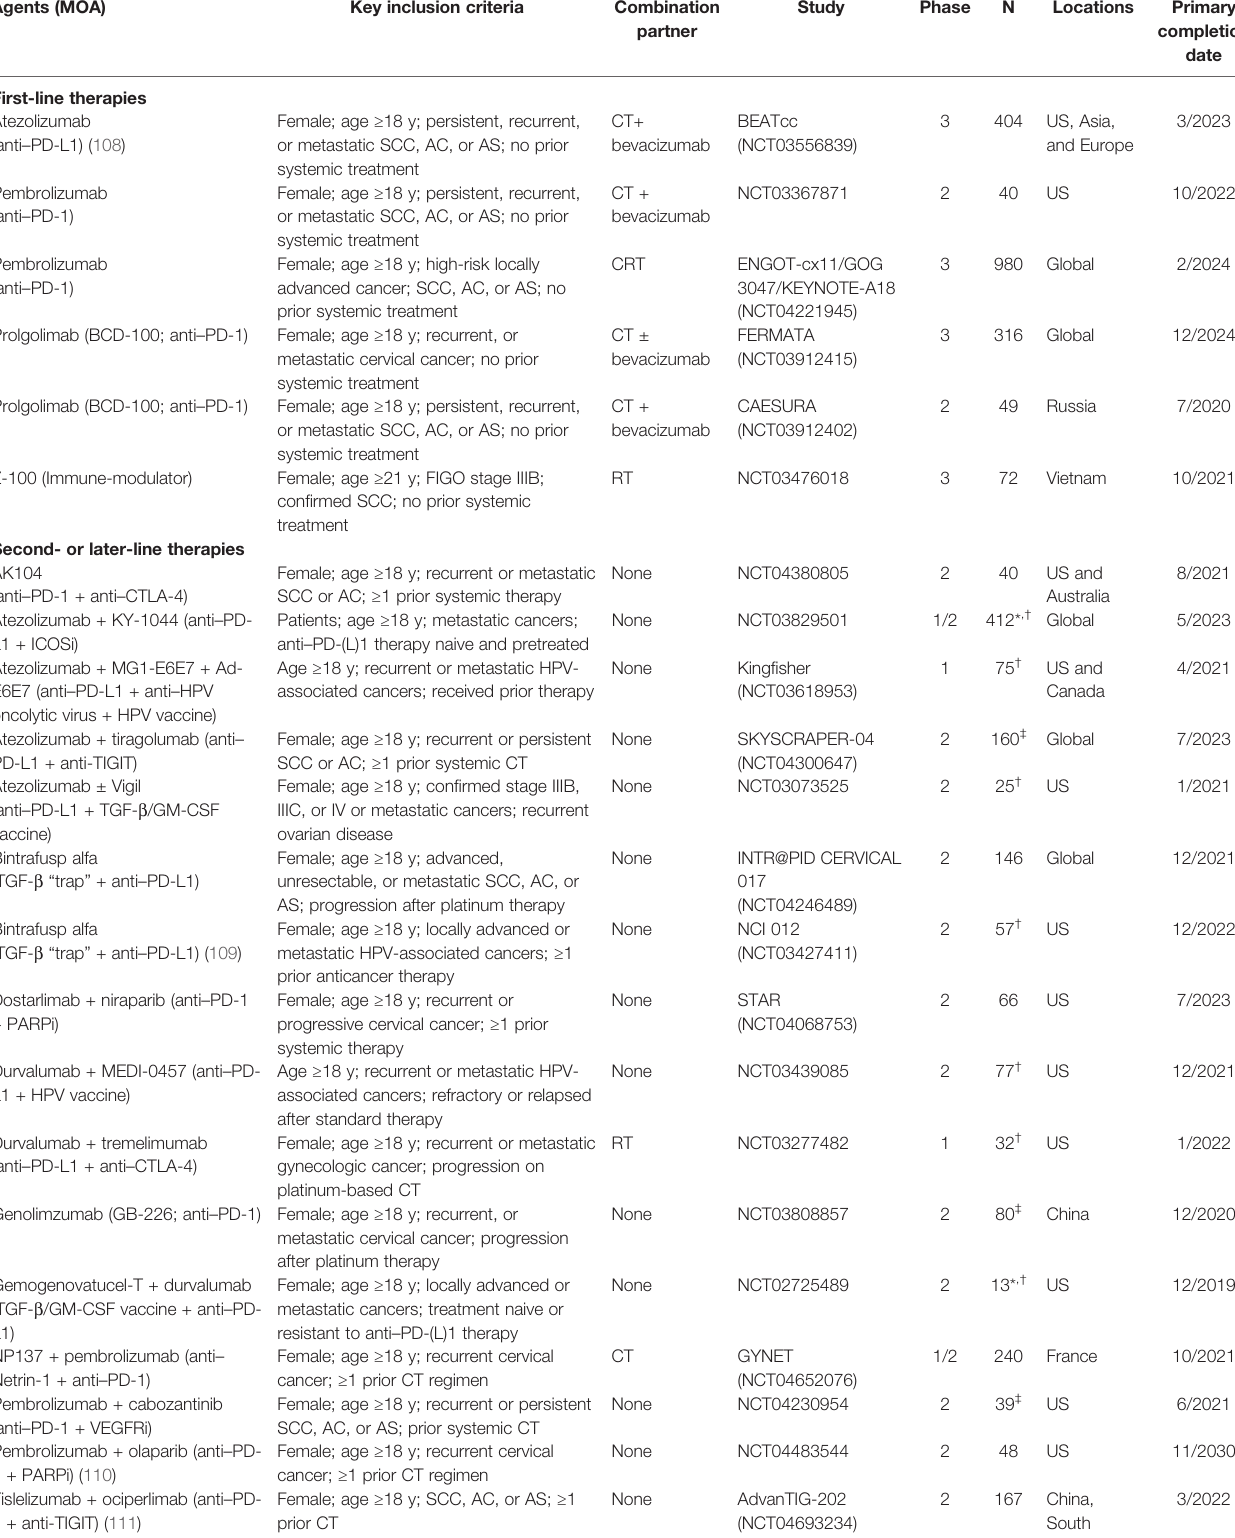
TABLE 2 | Ongoing clinical trials of immunotherapy agents in cervical